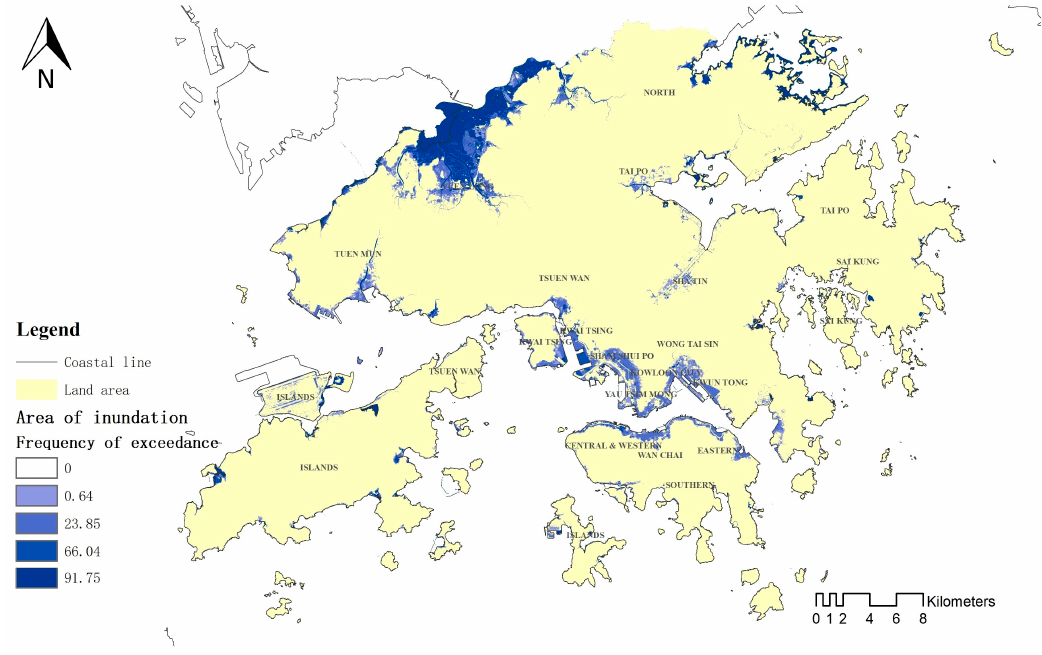
Figure 3. Coastal flooding exposure map under SSP 4.5. ISPRS Int. J. Geo-Inf. 2023 , 12 , x FOR PEER REVIEW